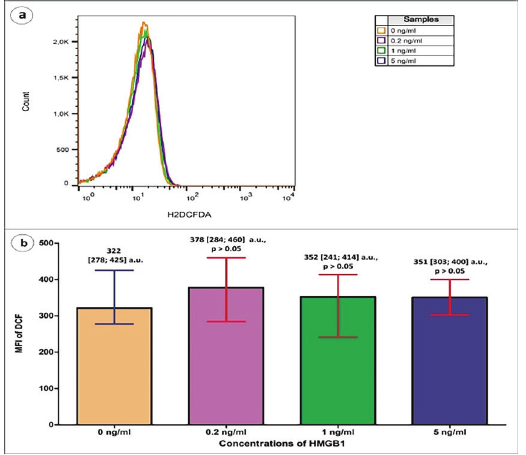
Figure 3 - HMGB1 did not promote ROS production in erythrocytes. H2DCFDA staining of red blood cells incubated with HMGB1 (0-0.2-1-5 ng per ml) for 24 h. Representative side scatter (SSC)/FL1 histograms are demonstrated (panel a). Generation of reactive oxygen species (ROS) was estimated by comparing the mean fluorescence intensity (MFI) values of dichlorofluorescein (panel